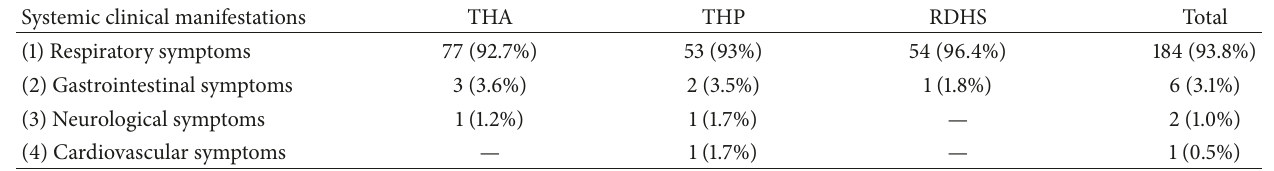
Table 2: Clinical manifestations of kerosene oil poisoning among children in rural Sri Lanka. Systemic clinical